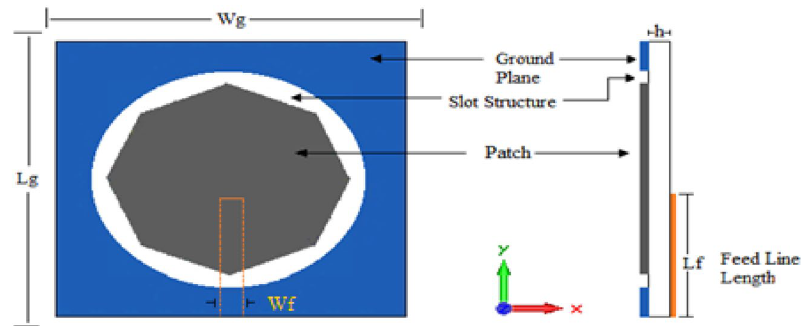
Figure 2. Antenna2 topology.